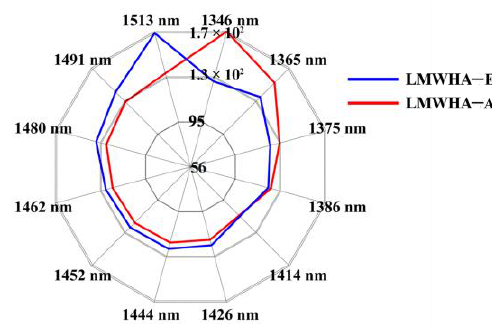
Figure 4. Aquagrams of LMWHA – A and LMWHA – E solutions tested at 25 °C.